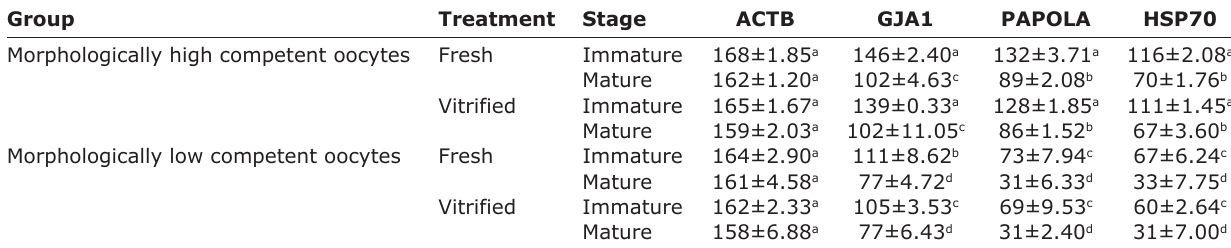
Table-2: Poly (A) tail length size of different transcripts in various oocytes developmental stages. Group